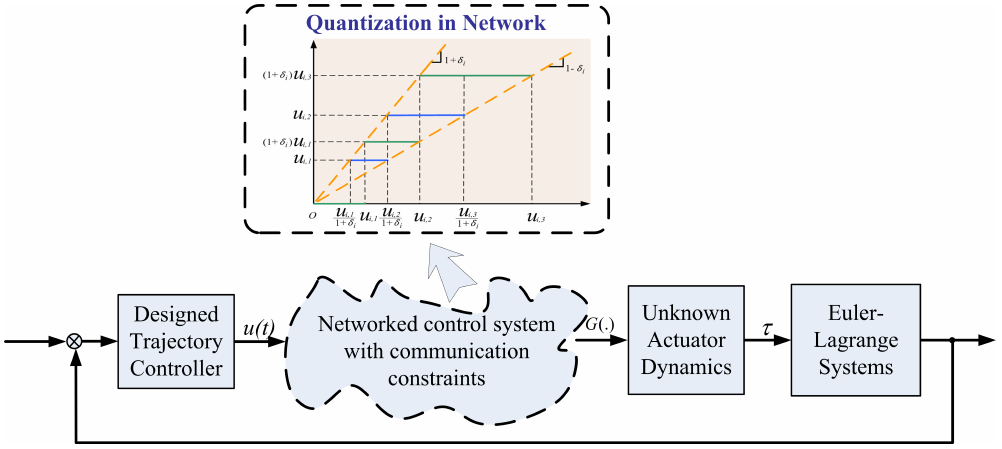
Figure 2. Networked Euler-Lagrange systems with unknown actuator